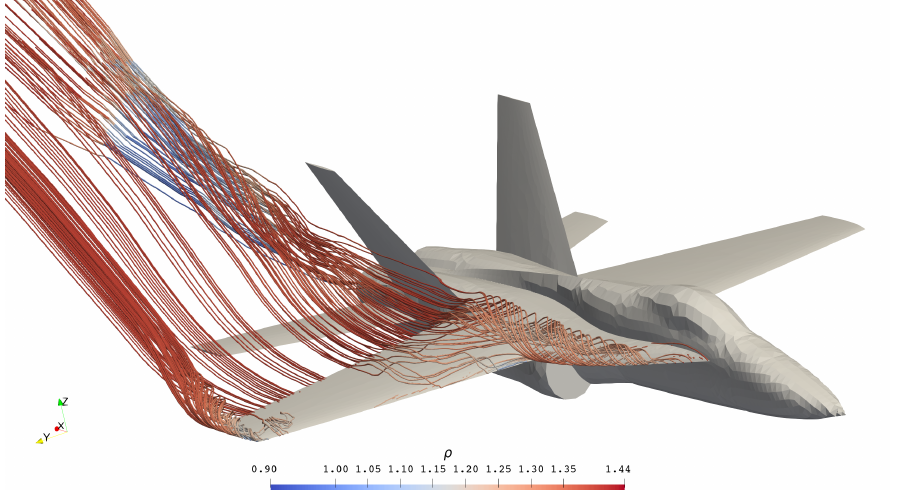
Figure 22. Streamlines given by the third-order solution of Problem 5.